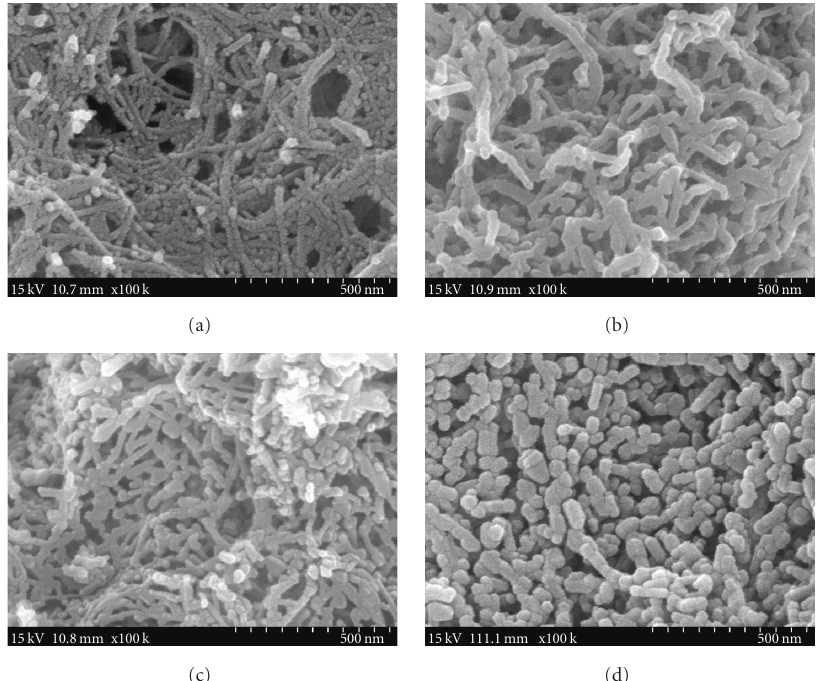
Figure 4: Scanning electron microscopy images of the calcined powders at 475 ◦ C for (a) 10min, (b) 60 min, (c) 120 min, and (d) 240 min in O 2 atmosphere.